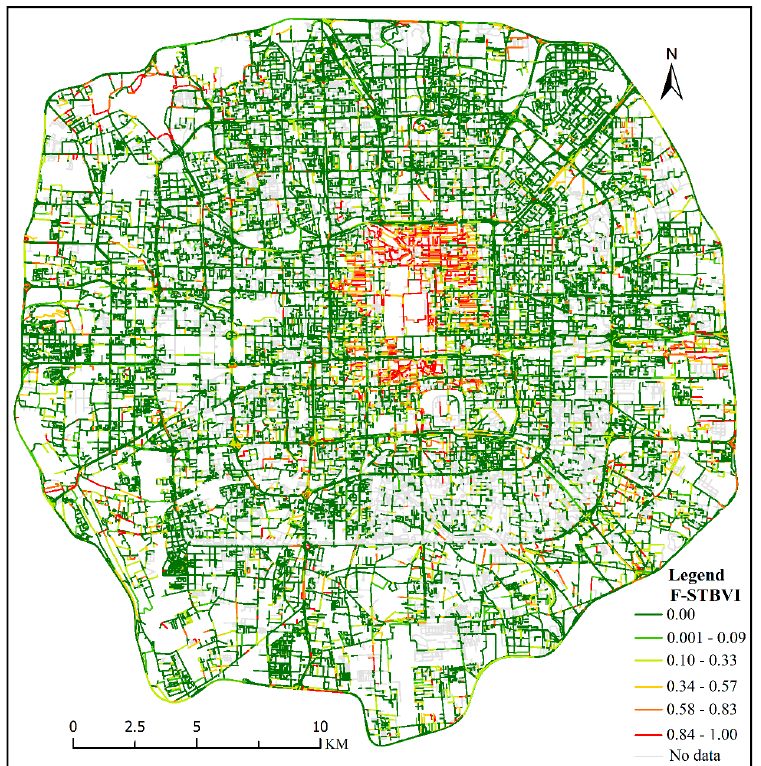
Figure 10. Spatial distribution of the STBVI of the official-style buildings.